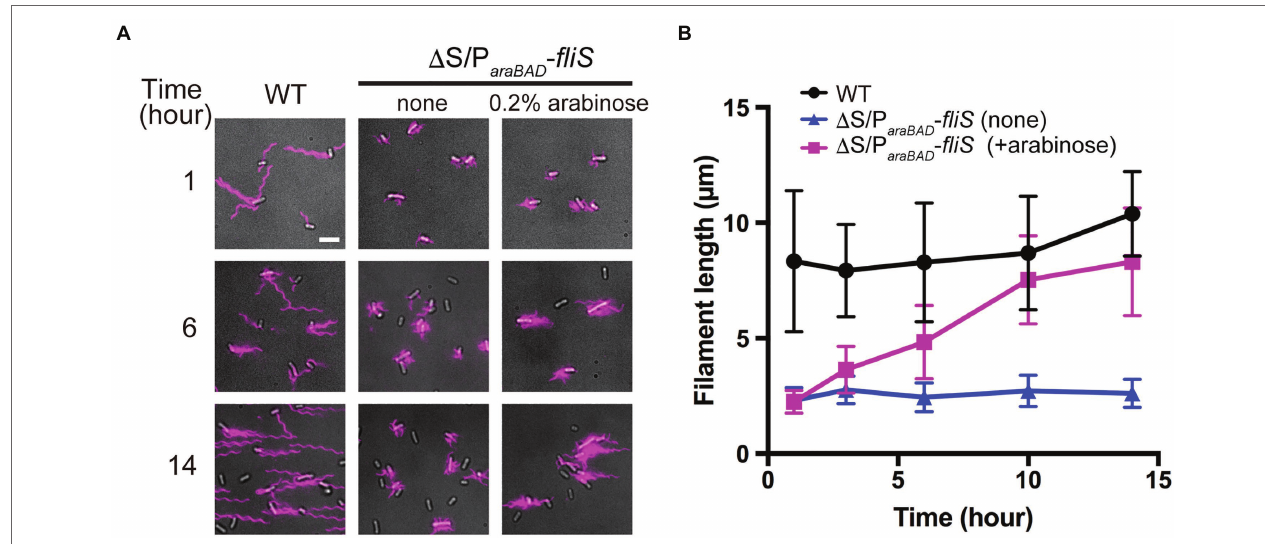
FIGURE 5 | Effect of FliS expression on filament growth. (A) Fluorescent images of ∆ fliS ∆ araBAD :: fliS ( ∆ S/P araBAD - fliS ) cells. The ∆ S/P araBAD - fliS cells were exponentially grown at 30 ° C to express and accumulate FliC subunits in the cytoplasm, and then, arabinose was added at a final concentration of 0.2%(w/v) to induce the expression of FliS from the araBAD promoter on the chromosome. Cells were collected at the indicated time intervals, followed by labelling their flagellar filaments with a fluorescent dye. Wild-type cell (WT) was used as the positive control. Scale bar, 5.0 μ m. (B) Average length of flagellar filaments. Filament length is the average of 50 filaments, and vertical lines are standard deviations (also see Supplementary Table 2